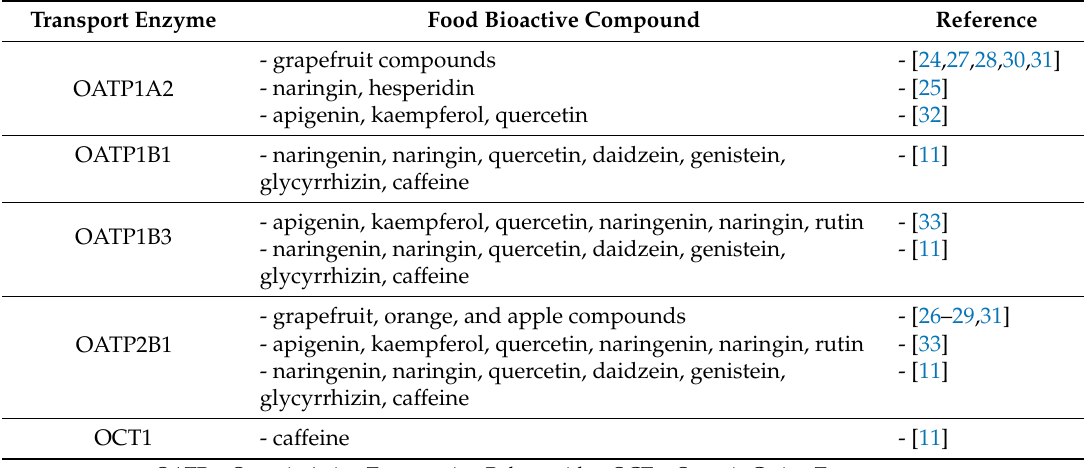
Table 1. Enteric and hepatic transporters of the solute carrier (SLC) superfamily that are targeted by food bioactive